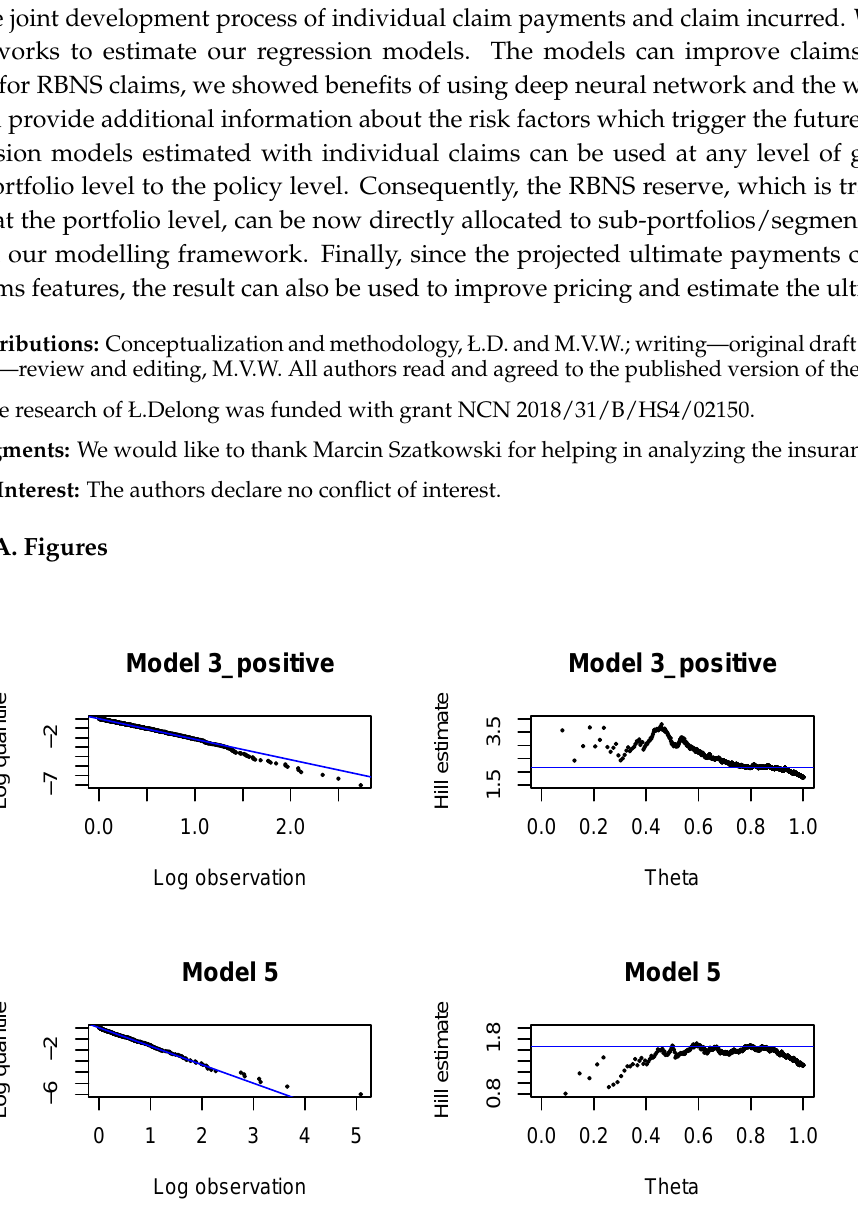
Figure A1. Pareto quantile plots and altHill plots for incremental payments and changes in claim incurred in k =